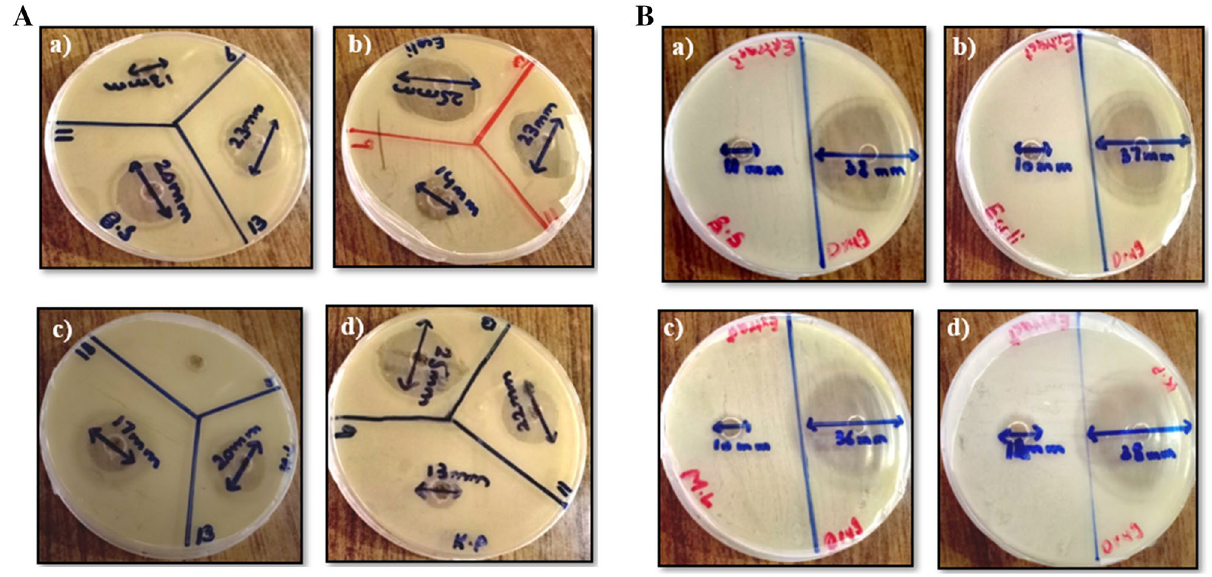
Figure 5. ( A) Antimicrobial activity of synthesized FeNPs against (a) Bacillus subtilis , (b) Escherichia coli , (c) Micrococcus leutu s, (d) Klebsiella pneumonia . ( B ) Antimicrobial activity of standard drug and extract of Phoenix dactylifera leaves against (a) Bacillus subtilis , (b) Escherichia coli , (c) Micrococcus leutu s, (d) Klebsiella